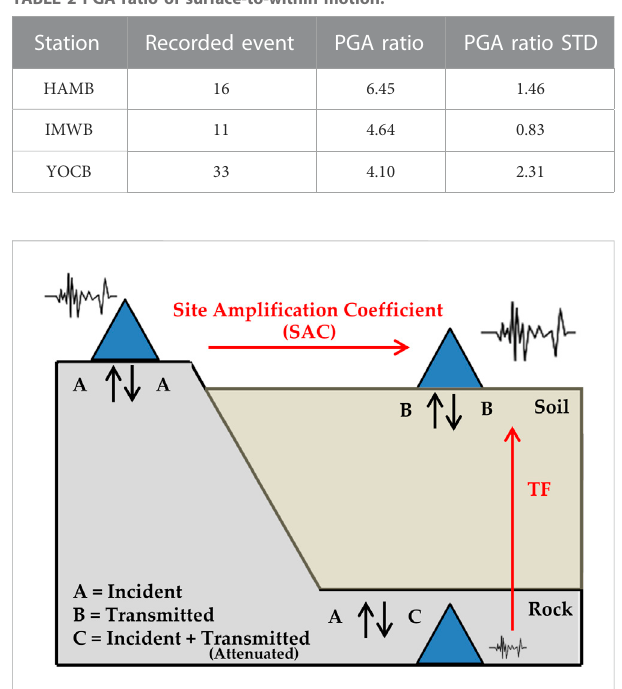
Schematic of difference between transfer function (TF) and site ampli fi cation coef fi cient